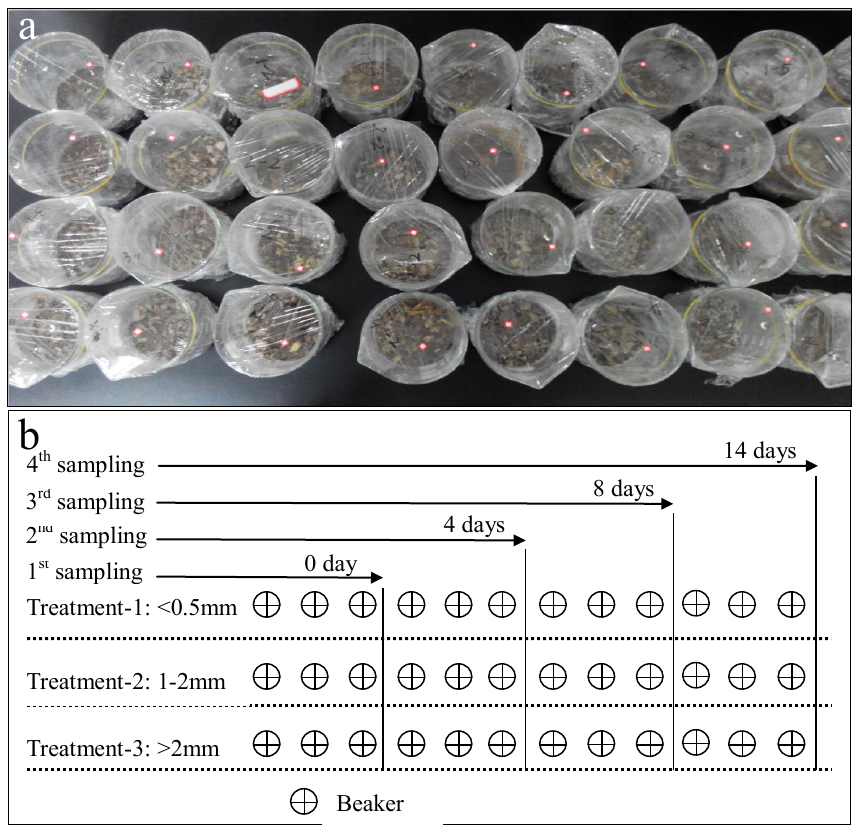
Figure 2: Incubation of different size aggregates (a) and sampling scheme (b)